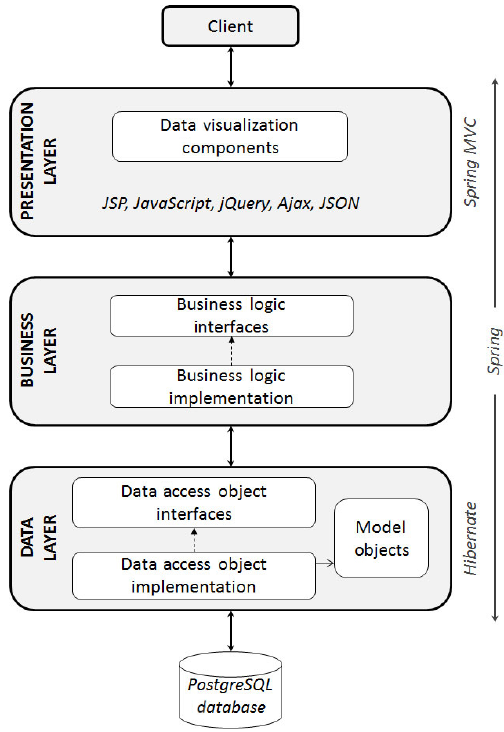
Figure 7. Architecture of the web application for entry and man- agement of avalanche